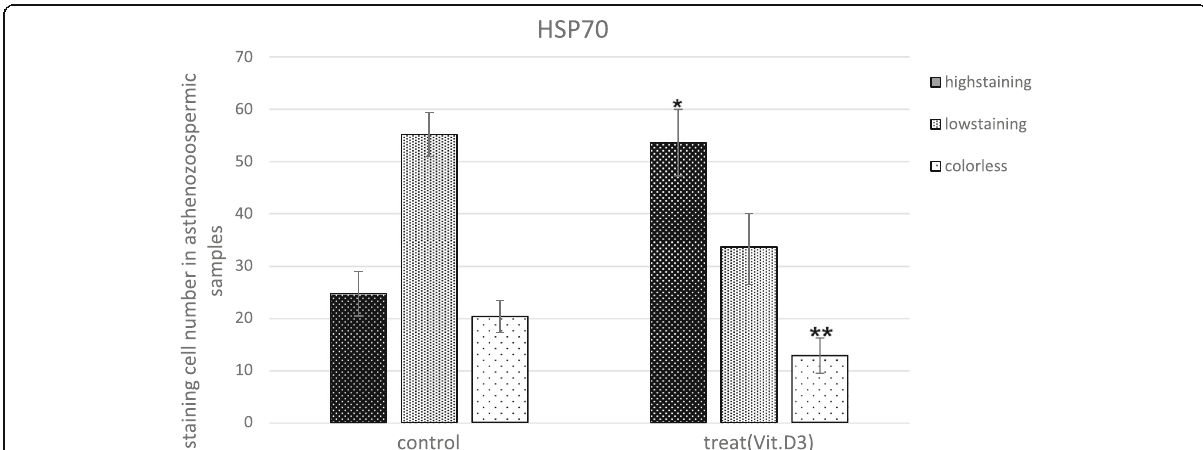
Fig. 3 Immunocytochemistry results for HSP70 protein in asthenozoospermic sample. Asterisk indicates a significant difference between the same type bars, *CI = 10.934 – 22.141 and **CI = − 7.0 to −